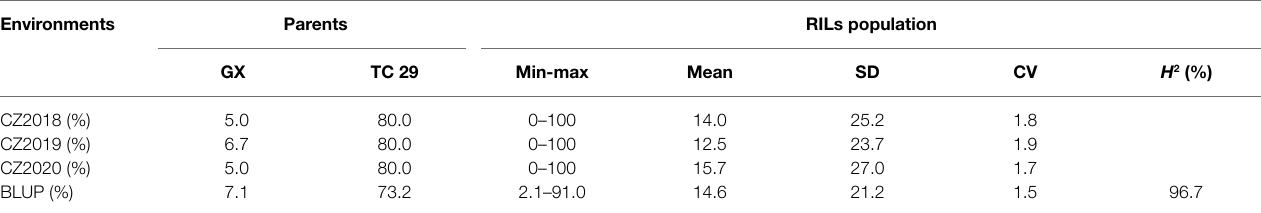
TABLE 1 | The summary of final disease severity (FDS) data for the recombinant inbred lines (RILs) population from the Gaoxianguangtoumai (GX) × Taichung 29 (TC 29) recorded in the fields at Chongzhou in 2018–2020. Environments Parents RILs population GX TC 29 Min-max Mean SD CV H 2